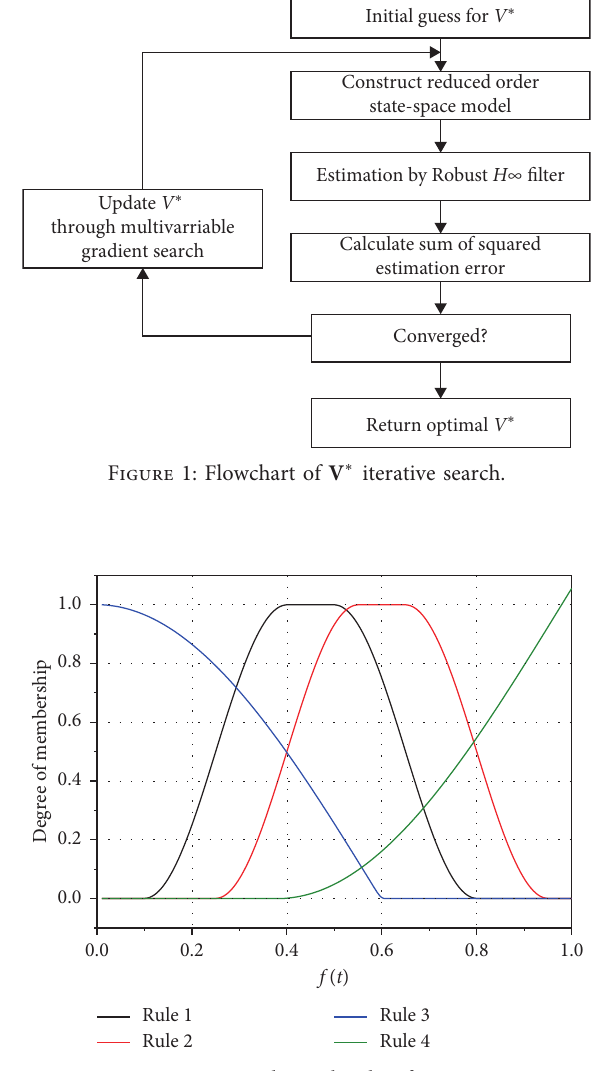
Figure 2: Initial membership